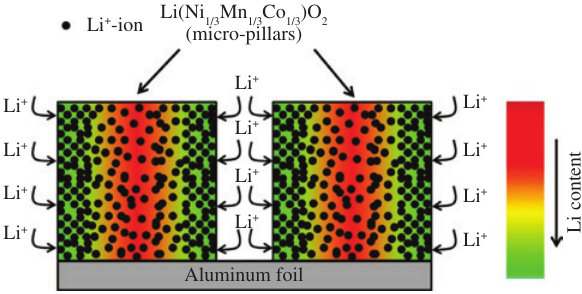
Figure 20: Schematic illustration for laser-structured NMC elec- trodes (in cross-section view) during electrochemical cycling at high discharge rates. Reprinted from